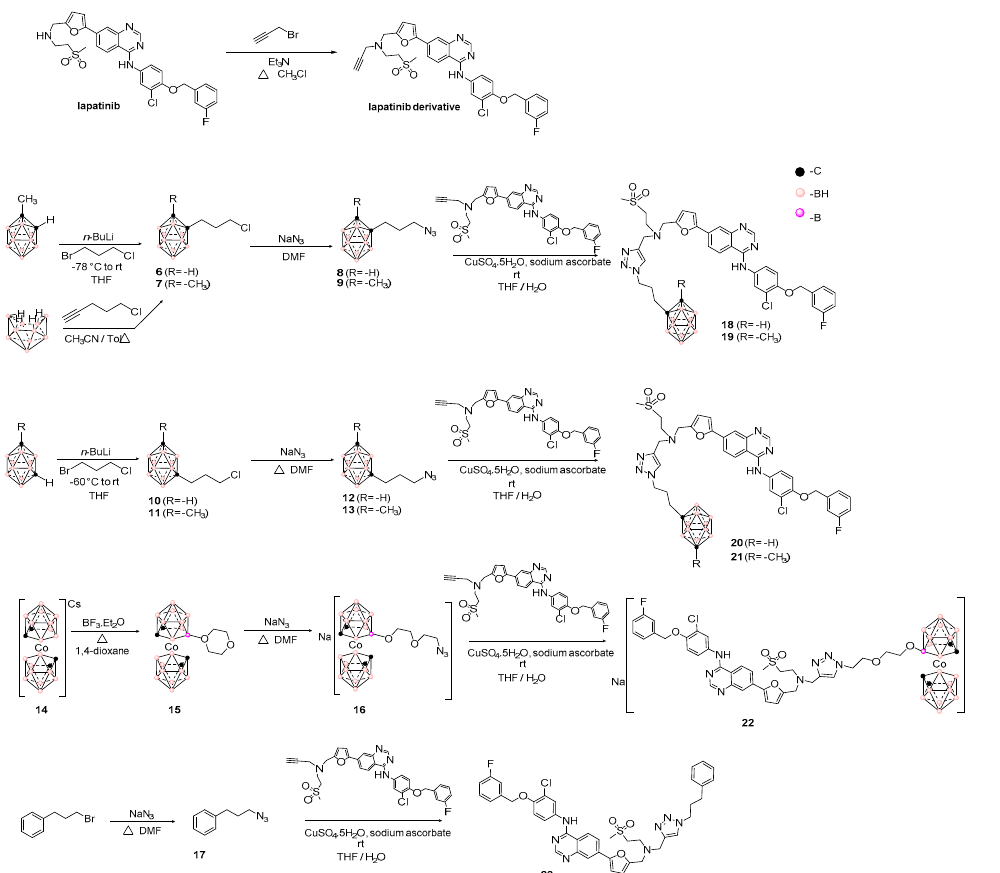
Scheme 1. Synthetic procedures used to prepare the hybrids carboranyl- and cobaltabis(dicarbollide)- lapatinib-sca ff old ( 18 – 22 ) and the bioisoster 23 . Table 1. In vitro behavior of hybrids 18 – 22 , bioisoster 23 , and reference compounds, as IC 50 ( µ M) or percentage of cells survival at 100 µ M (%), on HT-29, C6, and U87 MG cells and astrocytes. Selectivity indexes (SI) for selected hybrid and reference compounds. Hybrid IC 50,HT-29 1 IC 50,U87MG 1